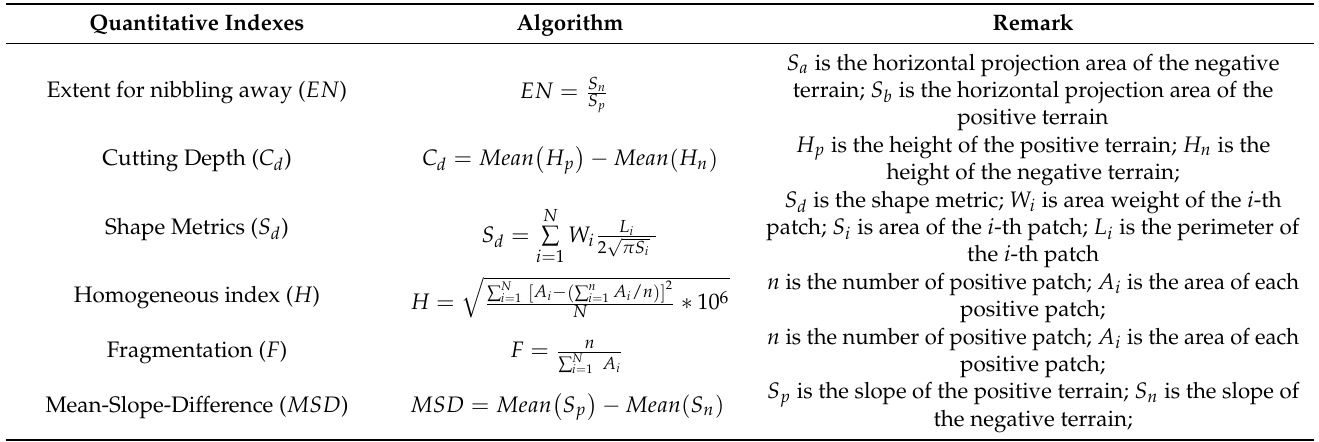
Table 3. The quantitative indexes of P–N terrain spatial structure and their corresponding